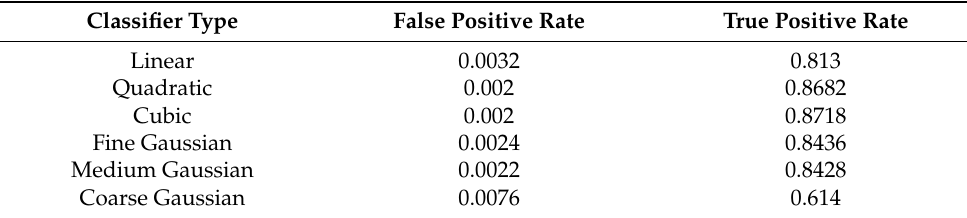
Table 4. False positive and true positive